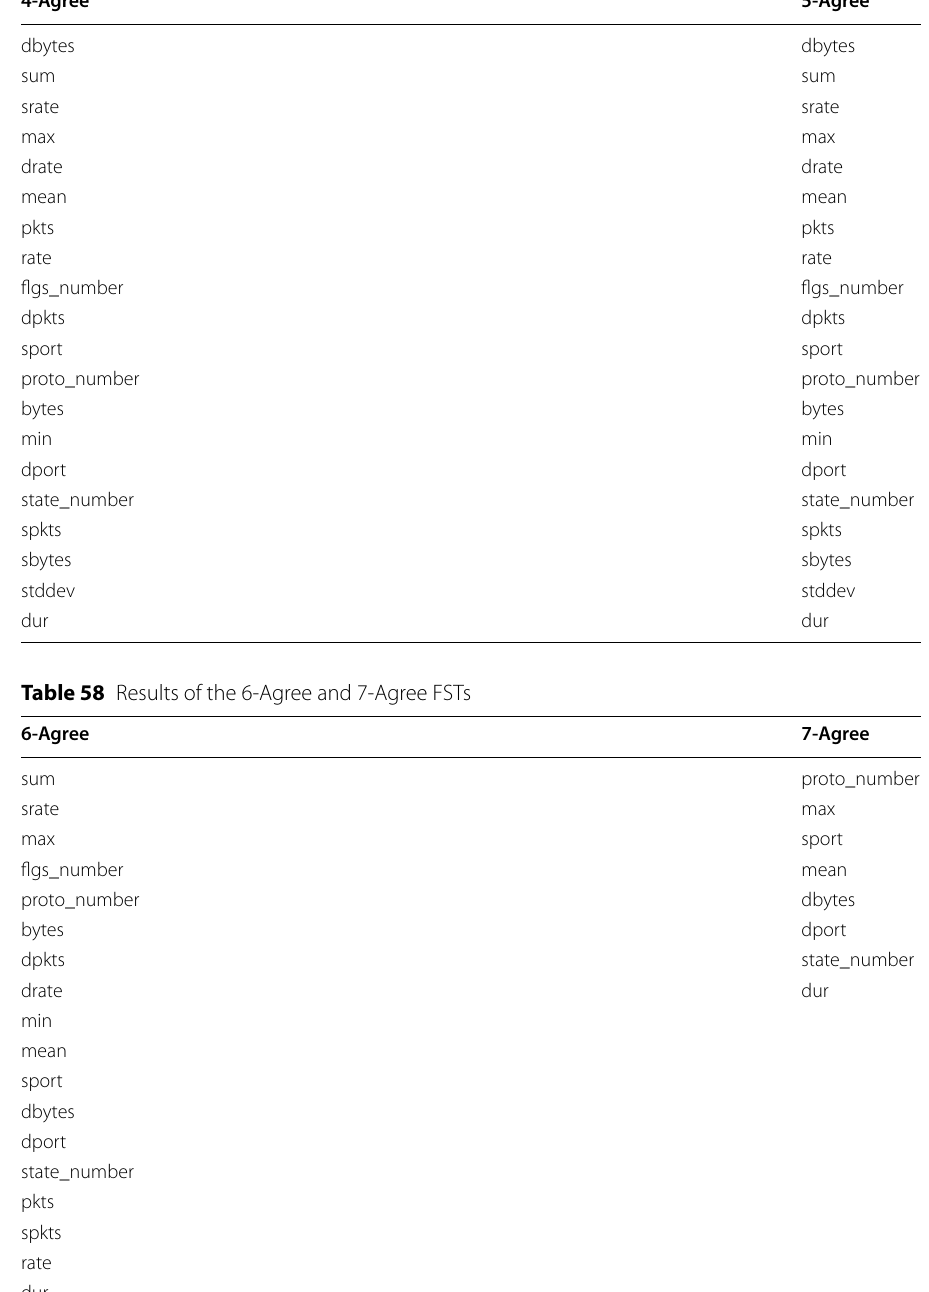
Table 57 Results of the 4-Agree and 5-Agree FSTs 4‑Agree